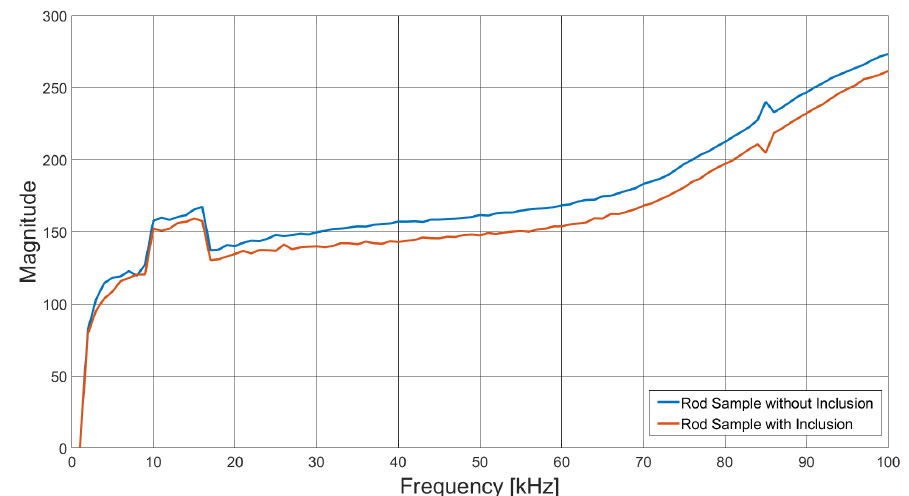
Figure 10. Image maximum ( max ( ∆ x ) ) as a function of frequency, for the rendered images of the aluminium rod sample individually ( ∆ V = V sgl − V bg ) and with the including object ( ∆ V = V both − V sgl